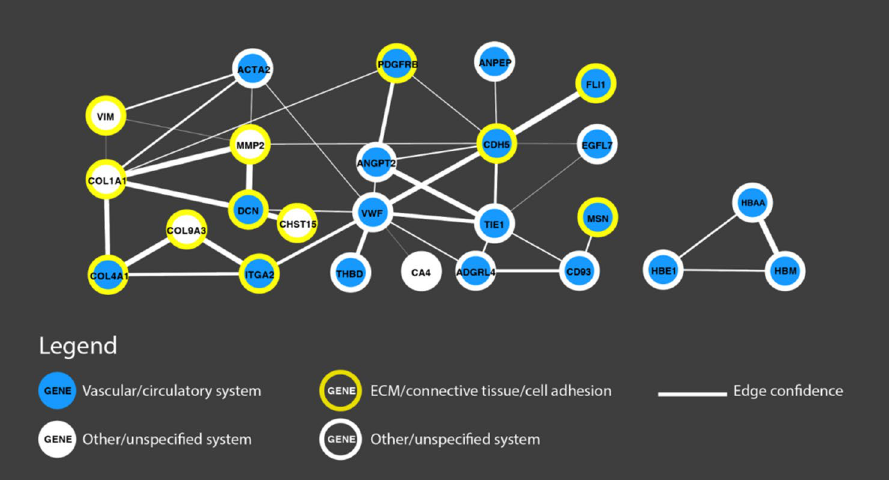
Figure 4. Interaction network of genes differentially expressed in the right vs left retina in the 6-h light exposure condition. Physical and non-physical interactions are represented, based on all available sources in Cytoscape 94 (text mining, experiments, databases, co-expression, neighbours, gene fusion and co-occurrence). Involved systems and functions (e.g., vascular/circulatory system, extracellular matrix (ECM)/connective tissue/ cell adhesion are coloured according to the legend, larger edges indicate stronger confidence in the